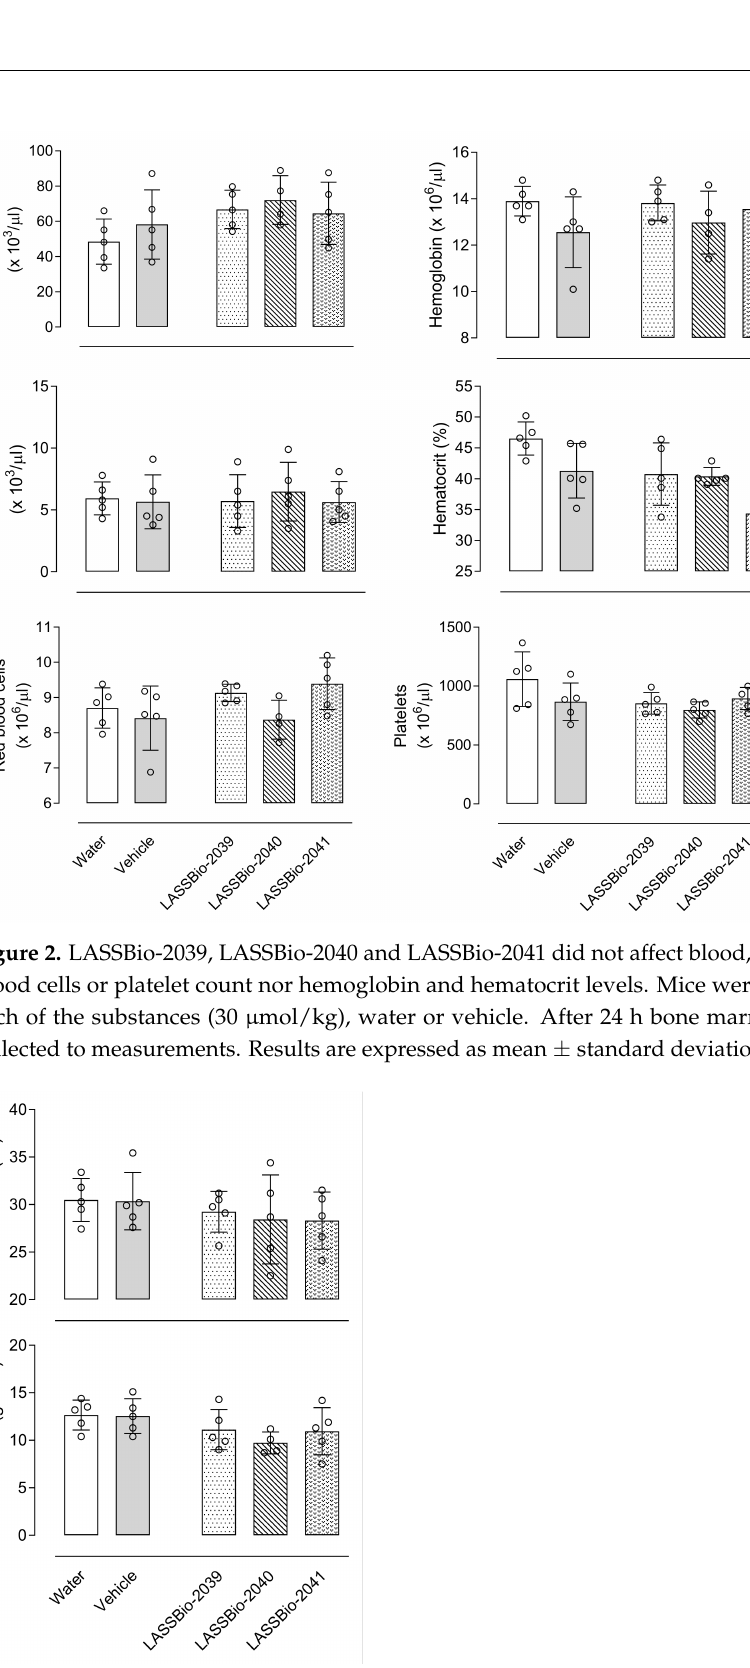
Figure 3. LASSBio-2039, LASSBio-2040 and LASSBio-2041 did not affect food and water intake. Mice were orally treated with each of the substances (30 µ mol/kg), water or vehicle. After 24 h the amount of water (in mL) or food (in grams) ingested were evaluated. Results are expressed as mean ± standard deviation ( n =